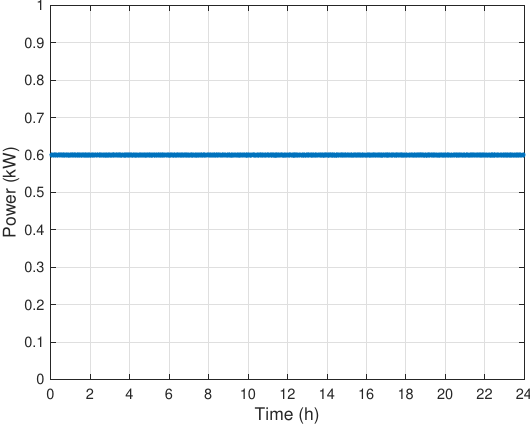
Figure A5. Latrine shelter equipment power.